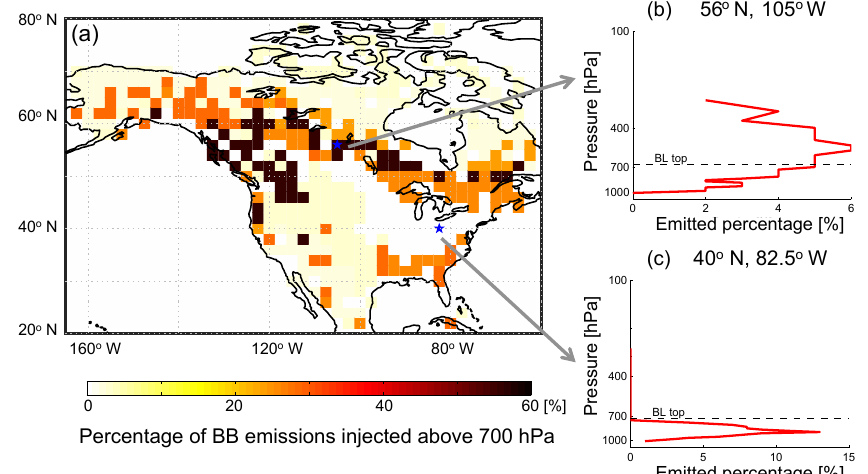
Figure 3. (a) Percentage of total-column biomass burning emissions injected above 700hPa over North America for July 2008, based on MISR observations. The two example locations shown in (b) and (c) are marked as blue stars. (b) Vertical profile of the percent of emissions in each model level over 56 ◦ N, 105 ◦ W. (c) Vertical profile of the percent of emissions in each model level over 40 ◦ N, 82.5 ◦ W. The dashed line indicates the averaged boundary layer top during this month. BB: biomass